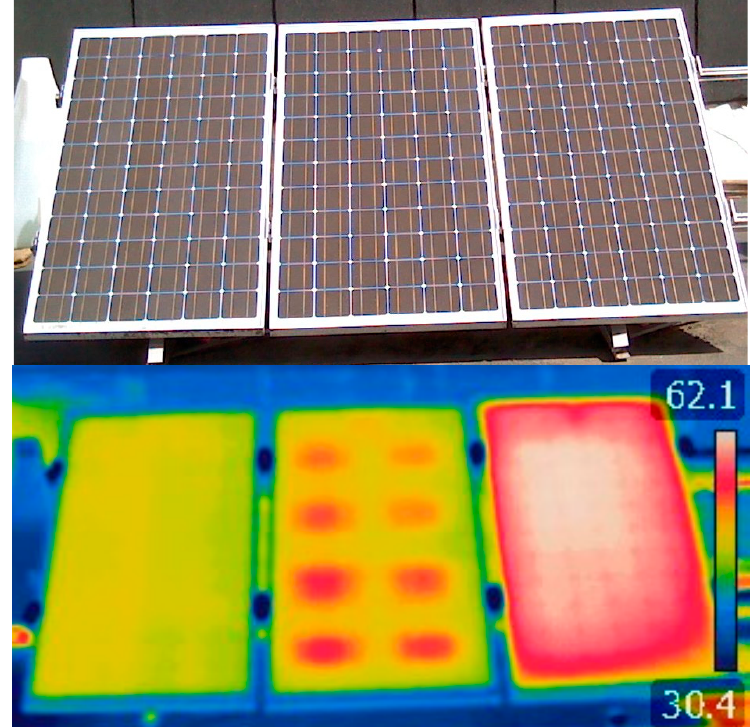
Figure 7. Visual and thermal images of the PV modules: without ( left ) and with ( center ) the battery storage system, and with covered backsheet ( right ), for ambient conditions T a ≅ 24 °C and G n ≅ 800 W/m 2 .